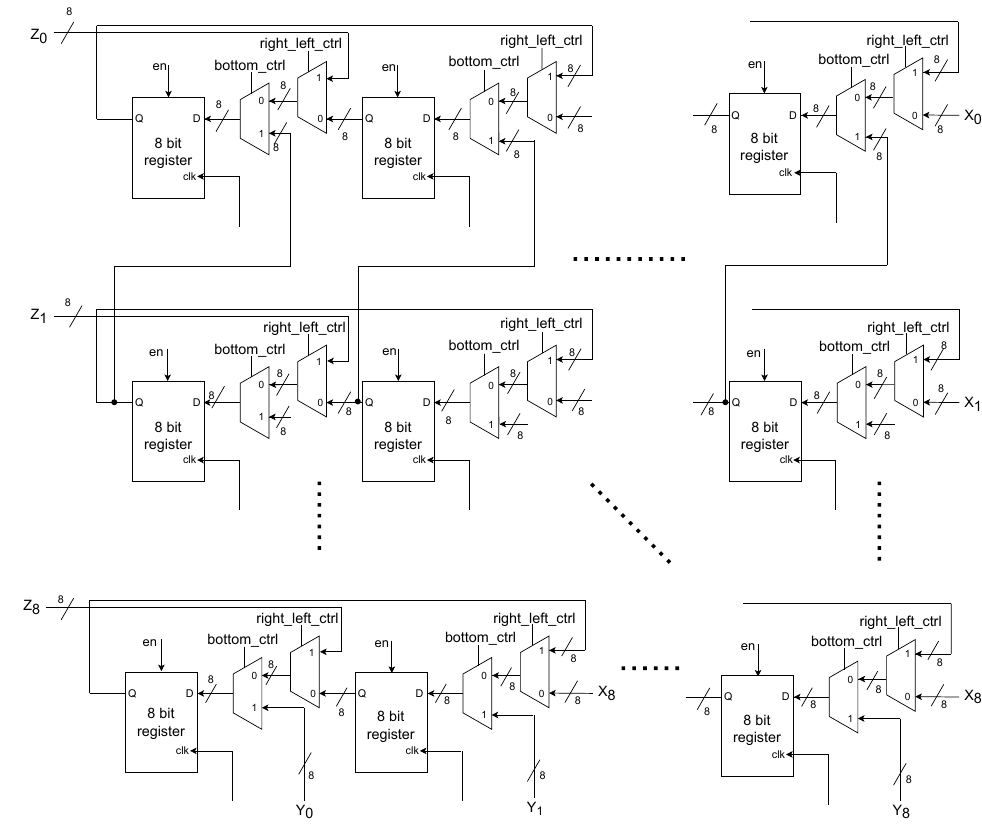
Figure 2. Pixel Buffer